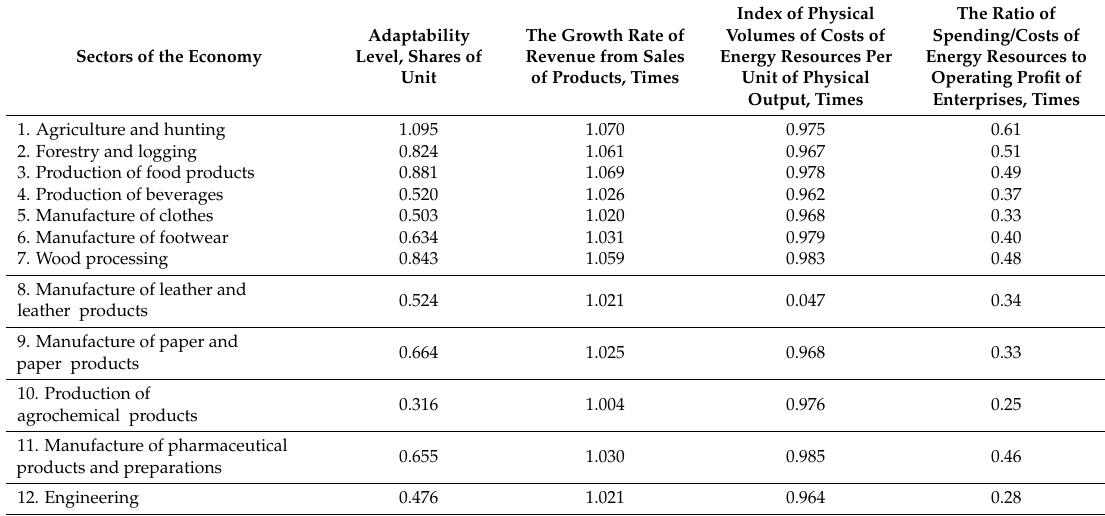
Table 5. Separate indicators that characterize or determine the level of adaptability of sectors of the Ukrainian economy to the prices increase for energy carriers in 2015 comparatively to 2014. Sectors of the Economy